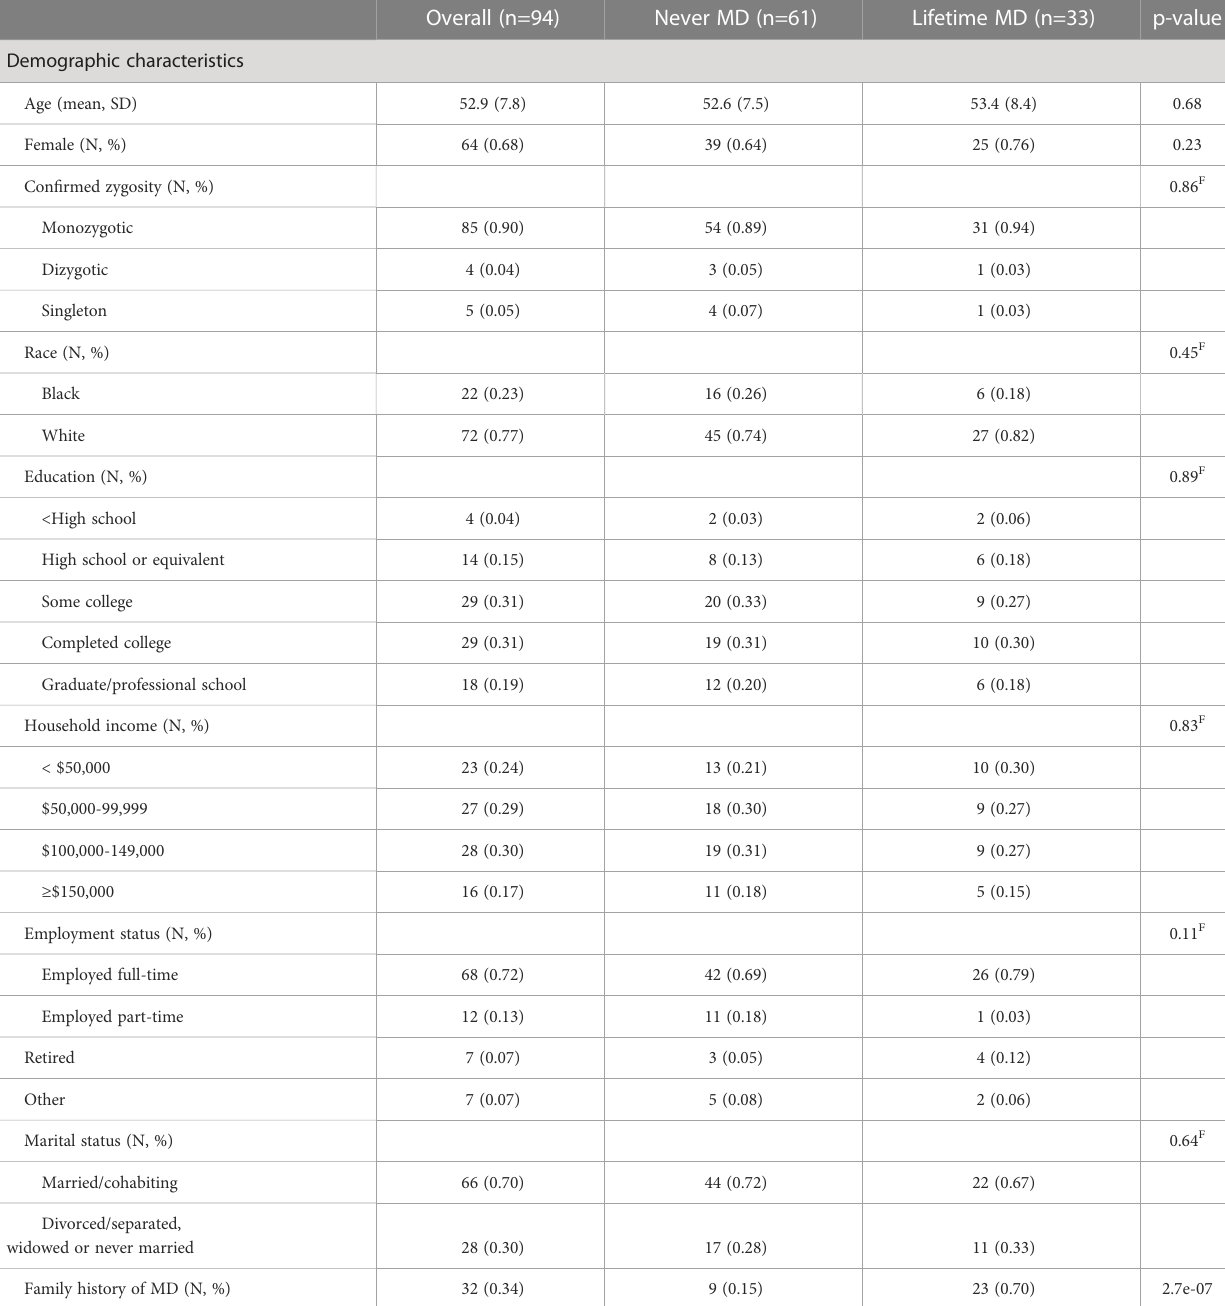
TABLE 1 Baseline characteristics of the Mood and Immune Regulation in Twins